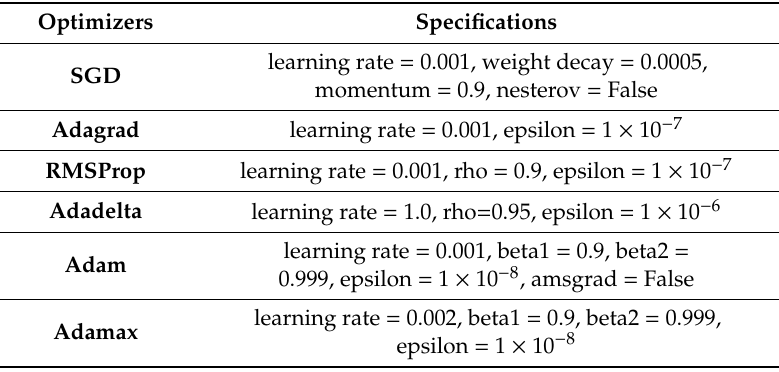
Table 1. Hyperparameters of the deep learning